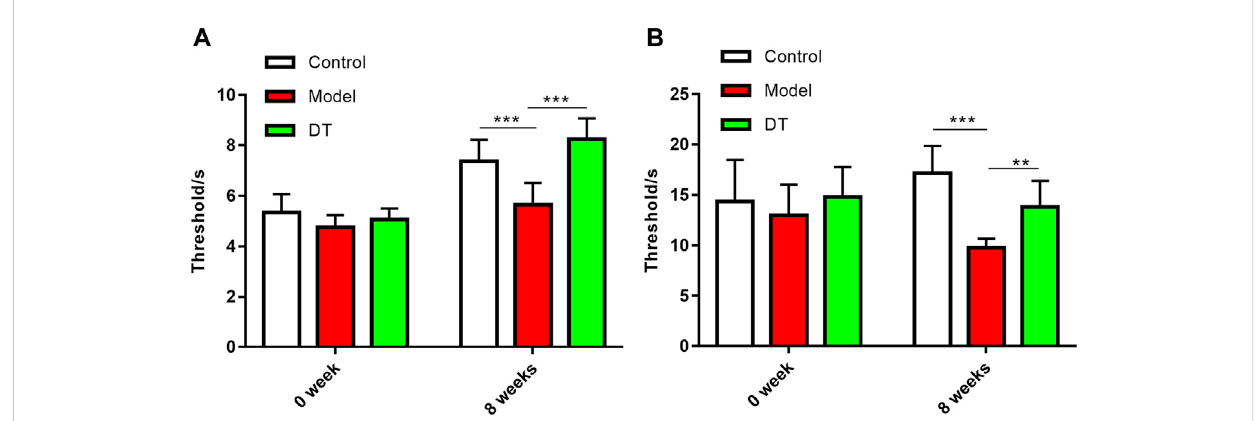
FIGURE 6 DT improved the sensitivity to pain in AM mice. (A) Mechanical hyperalgesia. (B) Thermal hyperalgesia. Data were expressed as means ± SD, **p < 0.01, ***p < 0.001.